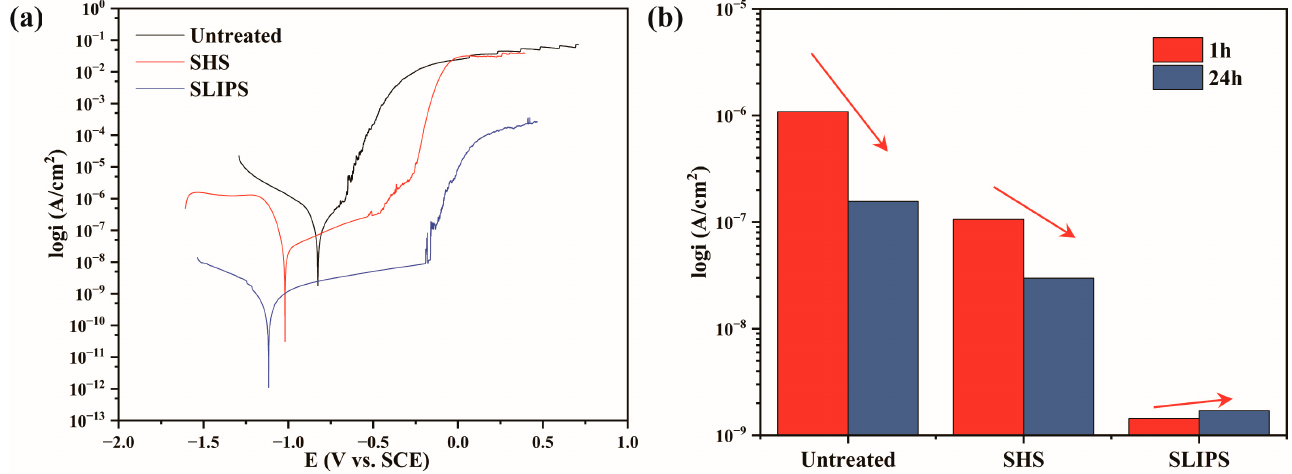
Figure 8. ( a ) Polarization curves after immersion in simulated seawater for 24 h; ( b ) Contrast for corrosion current density. Table 3. The characteristic parameters obtained from Polarization curves after immersion in simu ‐ lated seawater for 24 h.